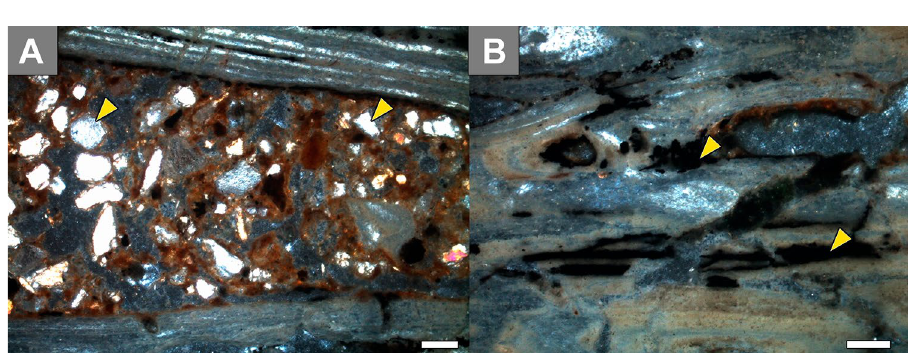
Figure 4. Taphonomic remarks in the microanatomy of LPP-PV-0200. ( A ) Poorly to moderately sorted subrounded to subangular mineral grains (arrow) and fragments of collapsed bone trabeculae (arrow) amidst the sedimentary matrix. Note the well-preserved birefringence of the bone apatite crystallites. ( B ) Opaque minerals infill the trabecular bone during weathering. All micrographs are in polarized light under crossed Nicols. Scale bar 100 µm. Photographs taken with Leica Application Suite (LAS) EZ version 1.6.0 X64. Figures were generated with Adobe Photoshop CC version 22.5.1